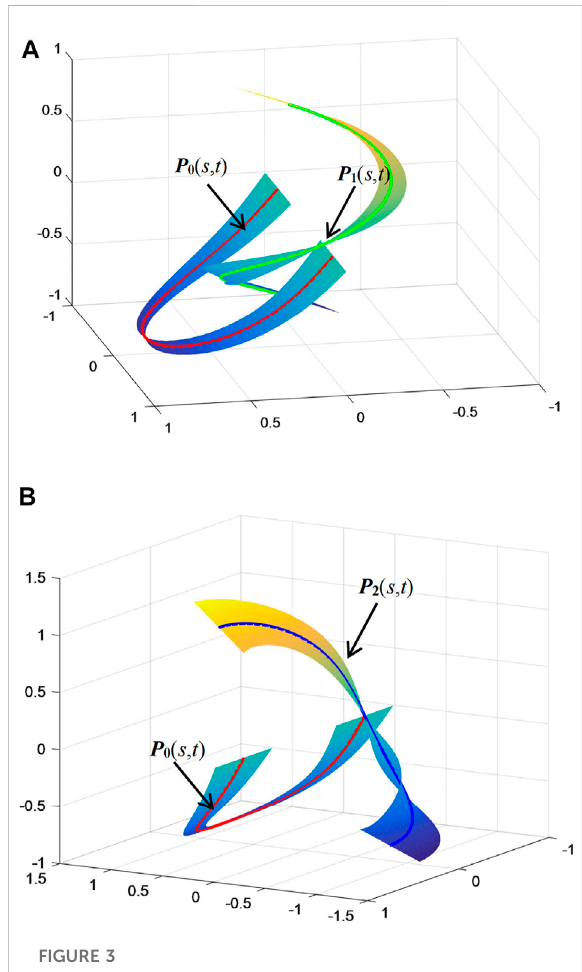
FIGURE 2 { P 0 ( s, t ) , P i ( s, t ) } interpolating { R 0 (s), R i (s)}, ( i = 1, 2 ) as common geodesics.